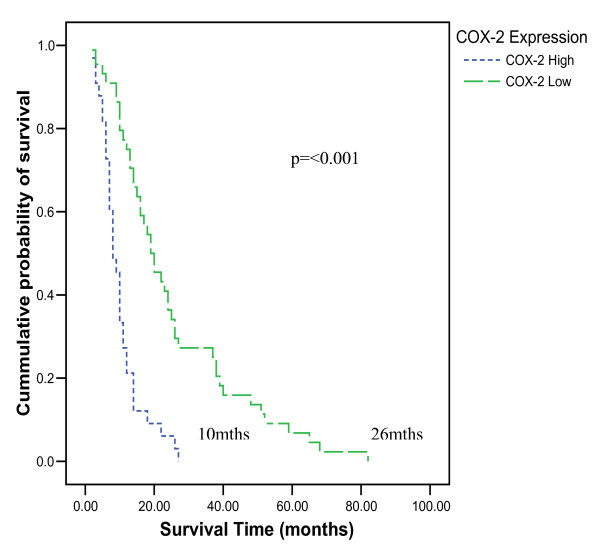
Kaplan-Meier survival curves according to COX-2 expression illustrates a poor survival (median survival of 10 mths) in patients with tumours expressing High (≥200) levels of COX-2 and better survival (median survival of 26 mths) in those with Low (<200) levels of COX-2.